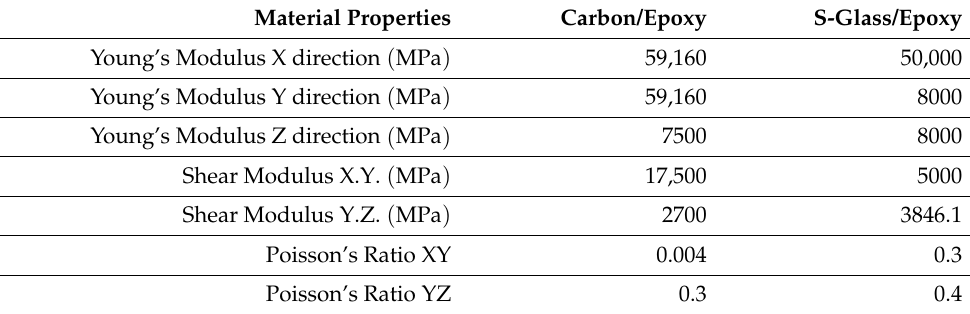
Table 2. Mechanical properties of Carbon/Epoxy